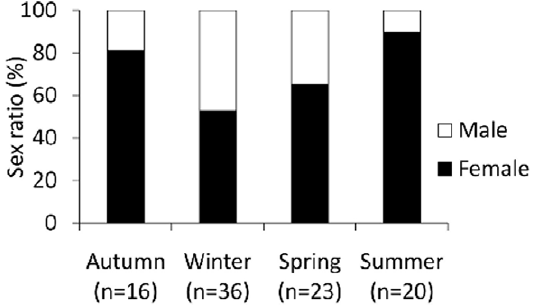
Figure 2. Seasonal gender ratios of Octopus cyanea . Seasonal gender ratios in Ningaloo Octopus cyanea